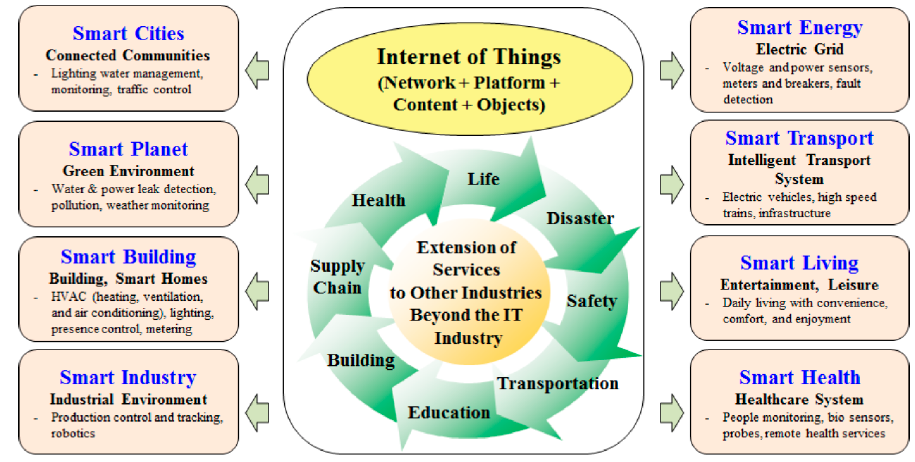
Figure 1. The Internet of Things applied in research by the current author. Source